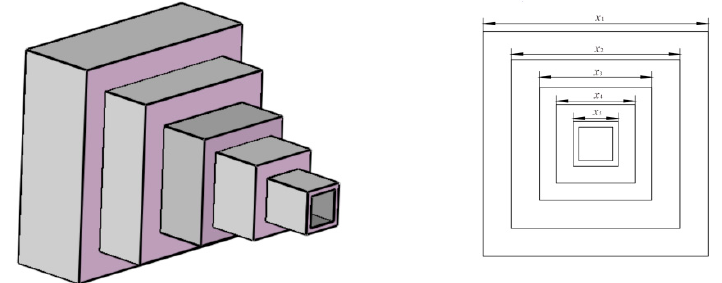
Figure 12. Model of cantilever beam design.